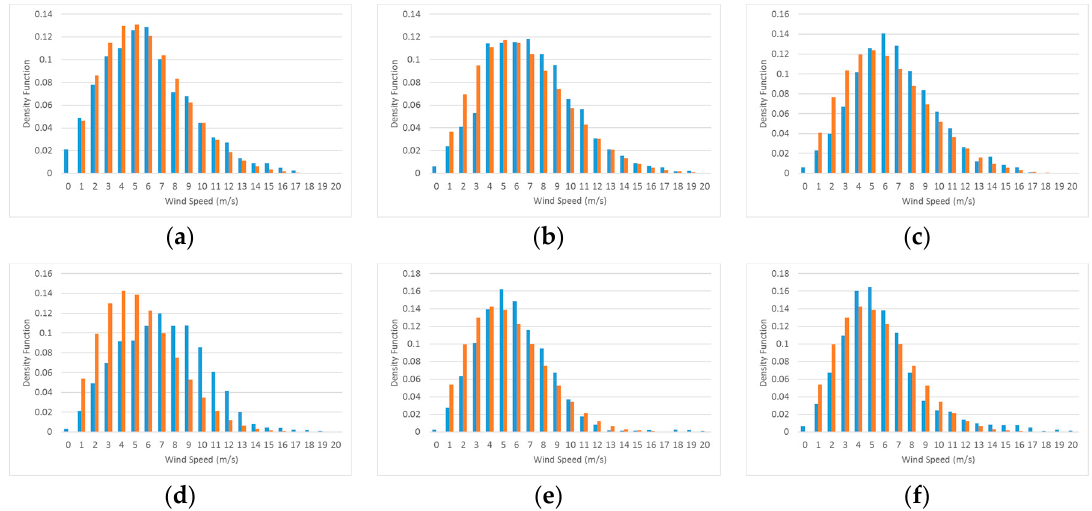
Figure 8. Six groups of samples of normalized histograms of wind speed, in blue, and fitted Weibull distribution, in orange, for group periods of 30 days each during WS season. Each graph corresponds to the following period ( a ) 01 / 01 / 2010–01 / 30 / 2010; ( b ) 01 / 31 / 2010–03 / 01 / 2010; ( c ) 03 / 02 / 2010–03 / 31 / 2010; ( d ) 04 / 01 / 2010–04 / 30 / 2010; ( e ) 05 / 01 / 2010–05 / 30 / 2010; ( f ) 12 / 21 / 2010–01 / 19 / 2011.